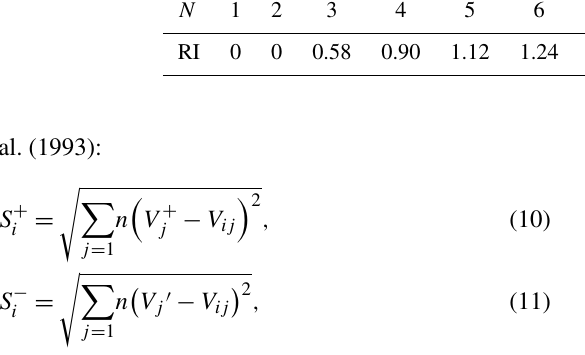
Table 3. Random inconsistency indices (RIs) for n = 1, 2...12 (after Saaty, 1980).